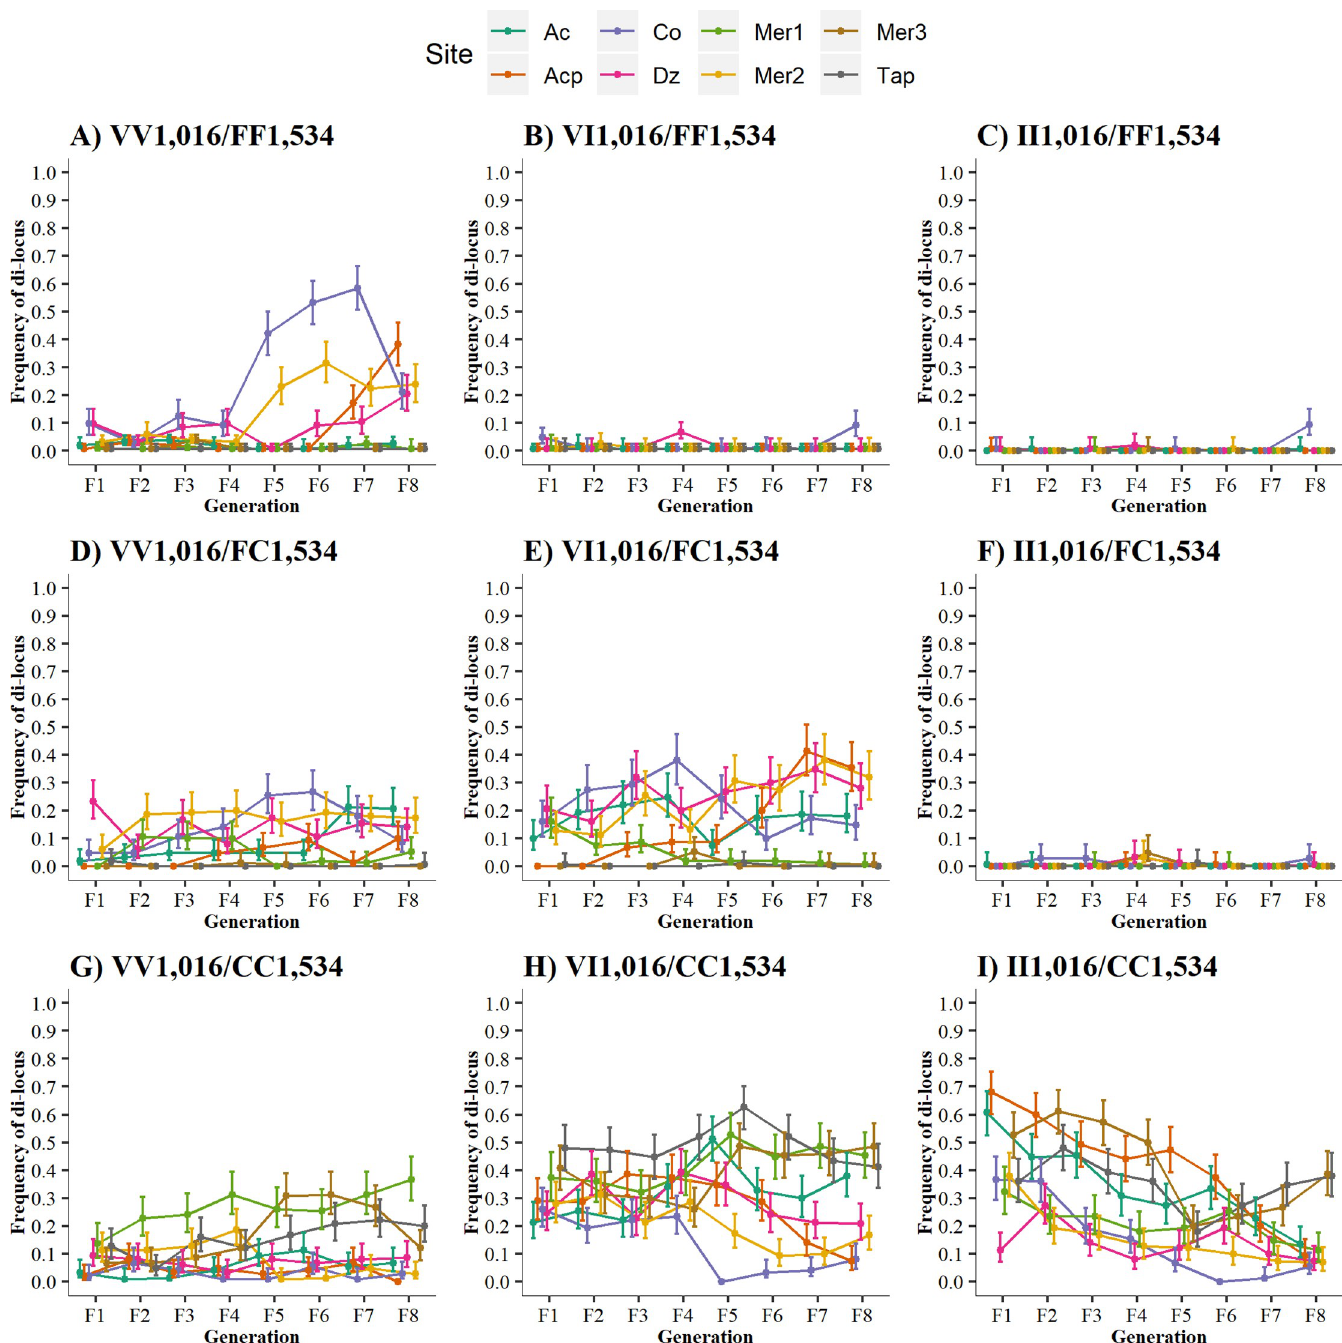
Fig 7. Frequency of the nine di-locus haplotypes over eight generations in the absence of insecticides.